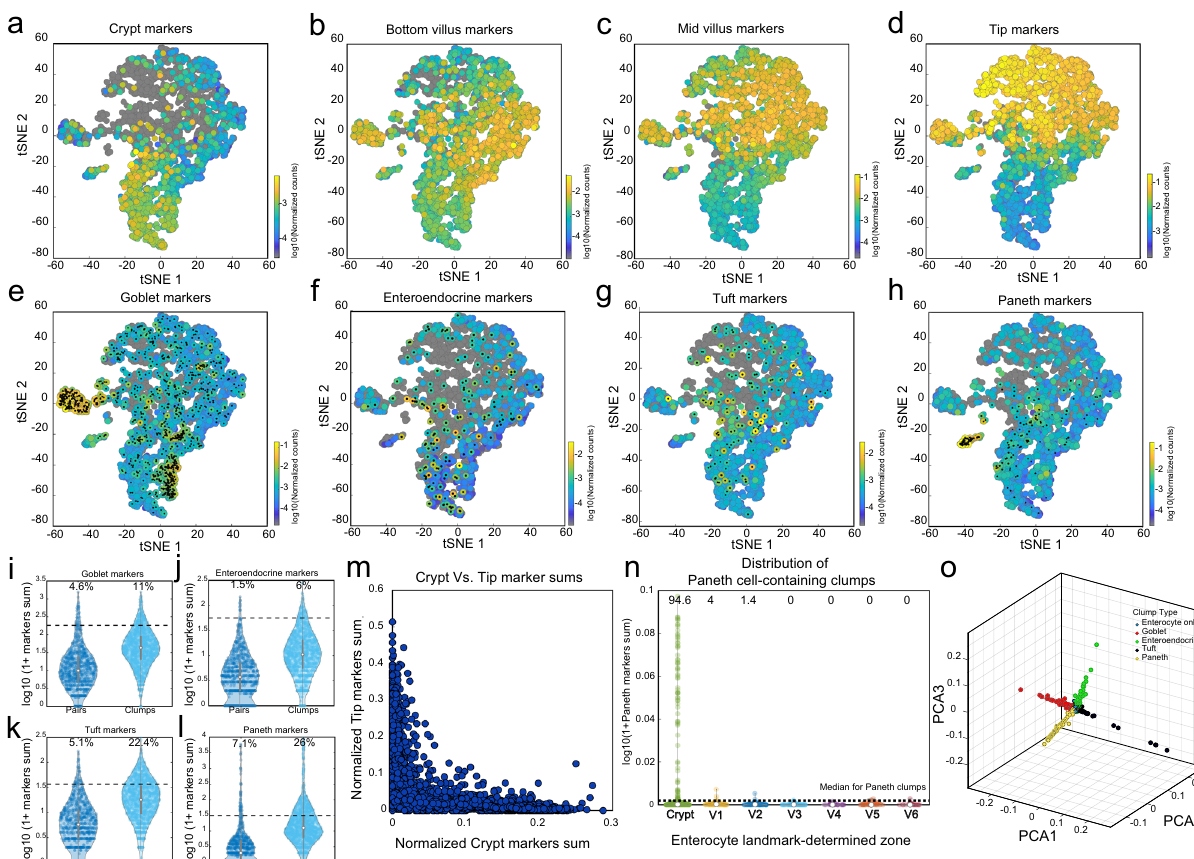
Fig. 2 ClumpSeq yields tissue fragments consisting of secretory and non-secretory cells. a – d tSNE plots of sequenced clumps, colored by log10 of summed expression of zonated enterocyte markers: a the crypt genes Mki67, Ccnb1, Ccnd1, Mcm2, Pcna, and Olfm4; b the bottom villus genes Nlrp6, Lypd8, Il18, Reg1 and Reg3a; c the mid-villus genes Slc5a1, Slc2a5, Slc2a2, Slc7a7, Slc7a8, Slc7a9; d the villus tip genes Ada,Nt5e and Slc28a2, Creb3l3, Apoa1, and Apob. e – h tSNE plots highlighting clumps containing secretory cells, marked by black dots. Plots colored by log10 of summed cell type marker genes (Supplementary Data 7, “ Methods ” ) for e Goblet, f Enteroendocrine, g Tuft and h Paneth cells. i – l Large clumps increase the capture rate of secretory cells. Shown are violin plots of summed secretory derived transcripts (expressed in over 50% of single secretory cells with a mean over 5 fold higher than in enterocytes) in pairs compared to larger clumps (Supplementary Data 6) for i Goblet, j Enteroendocrine, k Tuft and l Paneth speci fi c genes. Only crypt pairs and clumps were used to minimize effects from zonated genes. White circles are medians, gray boxes mark the 25 – 75 percentiles. Dashed horizontal lines indicate the median value in the respective single secretory cell type (Supplementary Fig. 7). Numbers show the percent of clumps above this threshold, which most probably contain the respective secretory cell type. n pairs = 2926, n clumps = 1862, examined over fi ve independent experiments. m Crypt and villus-tip enterocyte marker genes are not found in the same clumps, indicating the clumps did not form after tissue dissociation. n Violin plot of log10 of 1 + summed paneth markers (Supplementary Data 7) in all large (more than two cells) clumps, strati fi ed by inferred zone. White circles are medians. Dashed horizontal line indicates the median value in paneth containing large clumps. o Geometric classi fi cation of clumps. Representation of clumps in PCA space based on the type-speci fi c markers summed expression. Enterocyte-only clumps are at the origin, each ray contains a different secretory cell type ( “ Methods ” , Supplementary Fig. 3e, f, Supplementary Data